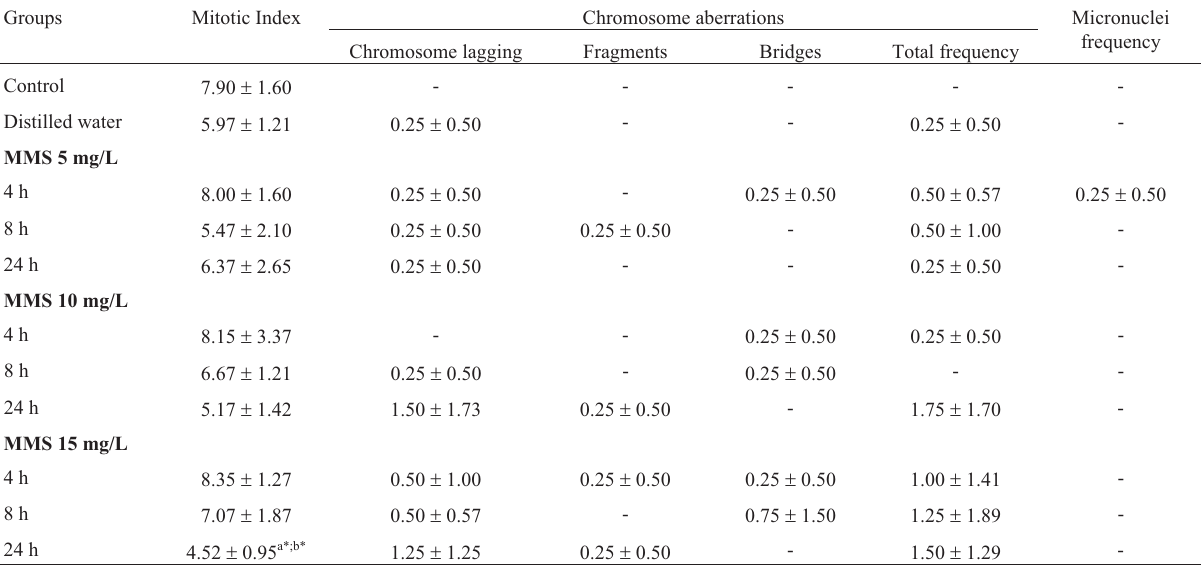
Table 4 - Mitotic index, frequency of chromosome aberrations and of micronuclei obtained in the cytogenetic tests on cells from the meristematic region (n = 4000) in roots of Phaseolus vulgaris L. accession GF007, exposed to methyl methanesulfonate (MMS).